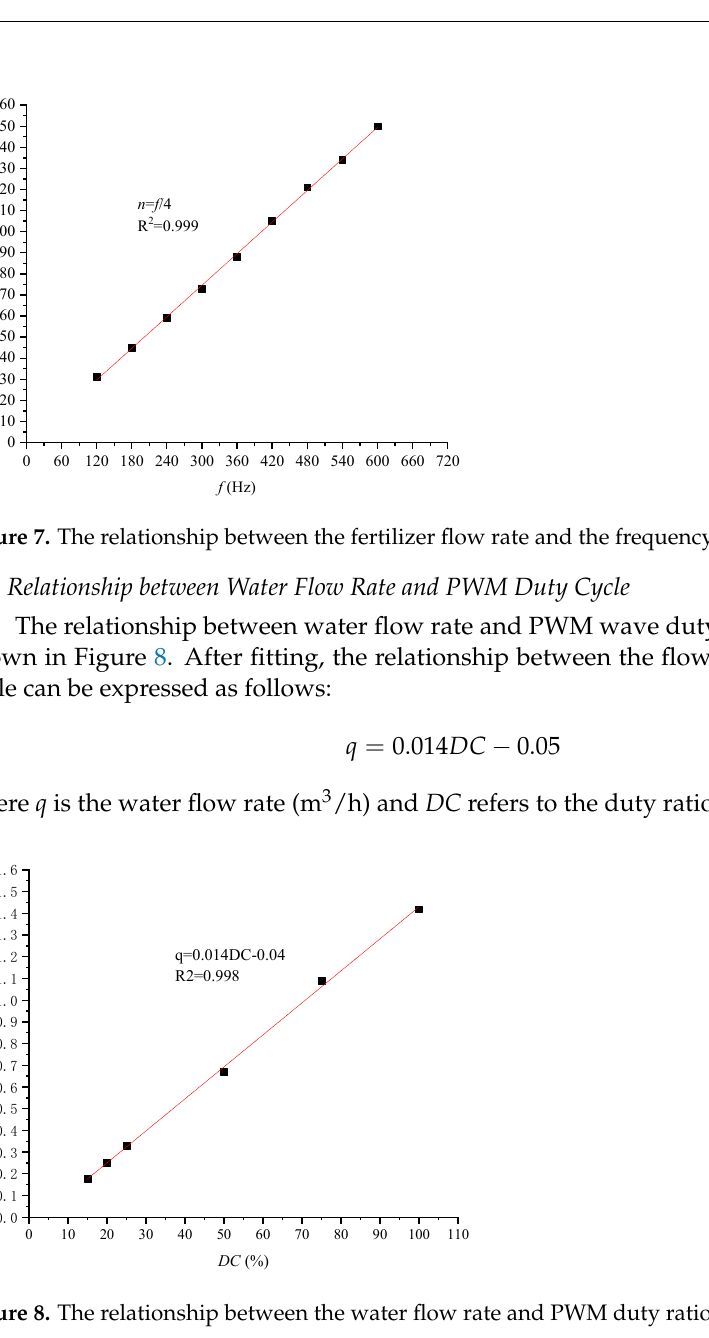
10 of 17 were measured every 1 min from the start of the process, and the experiment lasted 90 min. The change in the fertilizer solution’s concentration in the mixed fertilizer barrel over time was plotted for analysis. The control system was evaluated in terms of three perfor- mance indicators (i.e., stability, rapidity, and accuracy) to analyze its performance. The three indicators of the control system were represented by specific parameters: Stability consisted of the time taken by the control system to return to the set value after adjusting the concentration of the fertilizer solution when interference was recorded as the adjust- ment time. Rapidity represented the time required for the fertilizer solution’s concentra- tion to reach the set value from the beginning, denoted as the response time. Accuracy was the absolute value of the difference between the output value and the set value when the concentration of the fertilizer solution became stable, denoted as the steady-state error (Equation (6)). 4. Results and Analysis 4.1. Relationship between Fertilizer Flow Rate and PWM Wave Frequency The relationship between speed and PWM wave frequency after testing is shown in Figure 7. An obvious linear relationship between motor speed and PWM wave frequency was observed. After fitting, the relationship between motor speed and PWM wave fre- quency can be expressed by Equation (15): / 4 n f = (15) where n is the stepping motor speed (r/min) and f represents the pulse frequency (Hz). Substituting Equation (15) into Equation (13) yields the relationship between ferti-